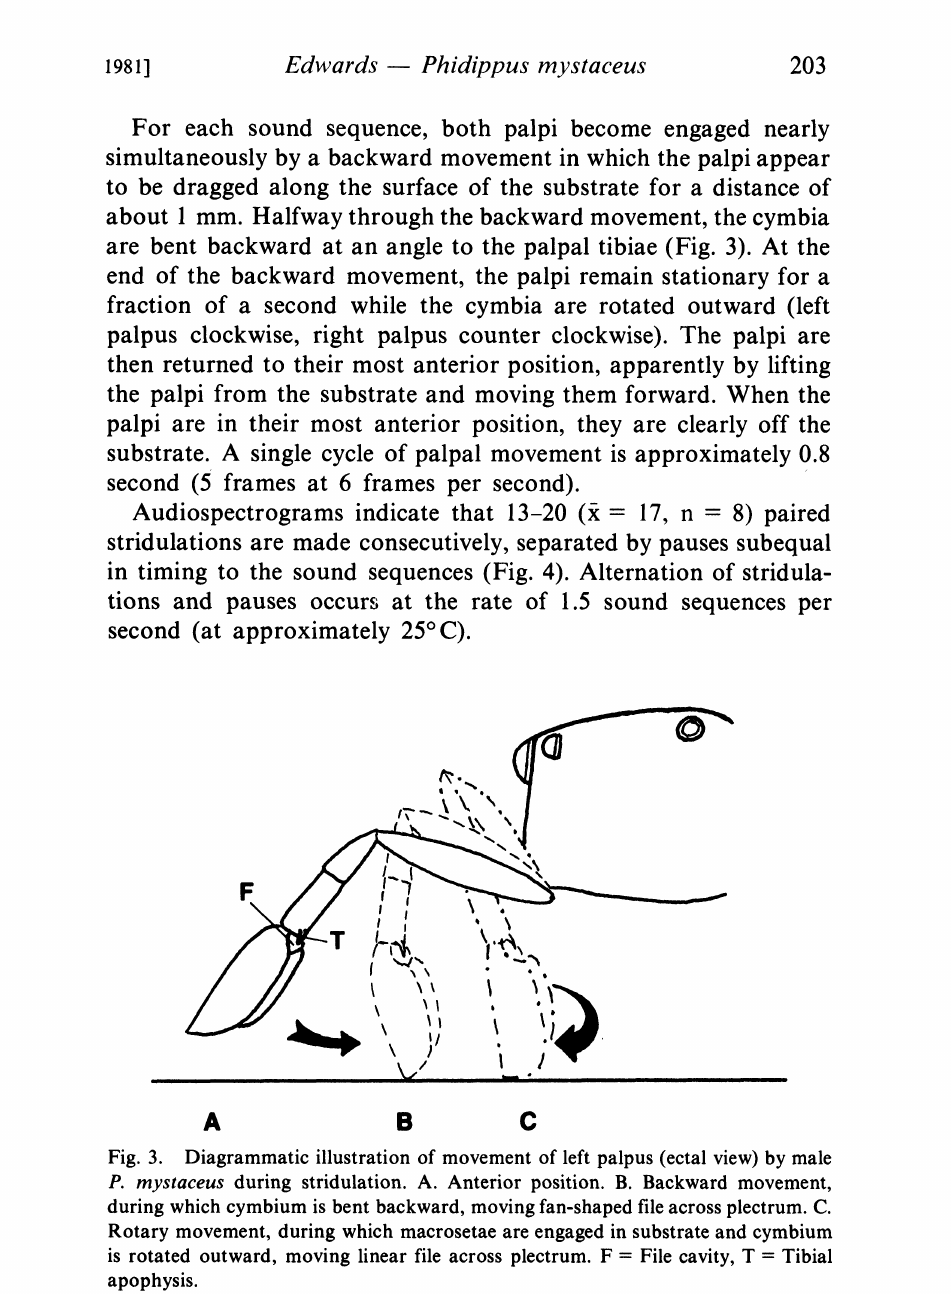
Fig. 3. Diagrammatic illustration of movement of left palpus (ectal view) by male P. mystaceus during stridulation. A. Anterior position. B. Backward movement, during which cymbium is bent backward, moving fan-shaped file across plectrum. C. Rotary movement, during which macrosetae are engaged in substrate and cymbium is rotated outward, moving linear file across plectrum. F File cavity, T Tibial